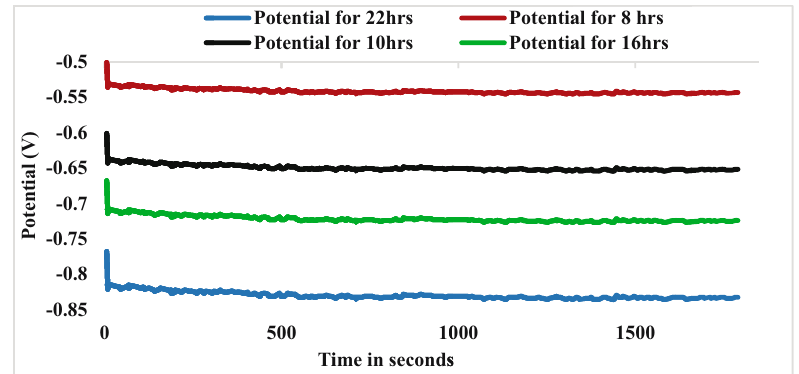
Figure 9: OCV plot for sample AH 5 TO AH 8 .